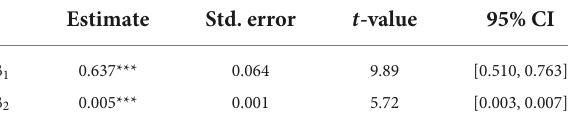
TABLE 4 Coefficients of the segmented regression